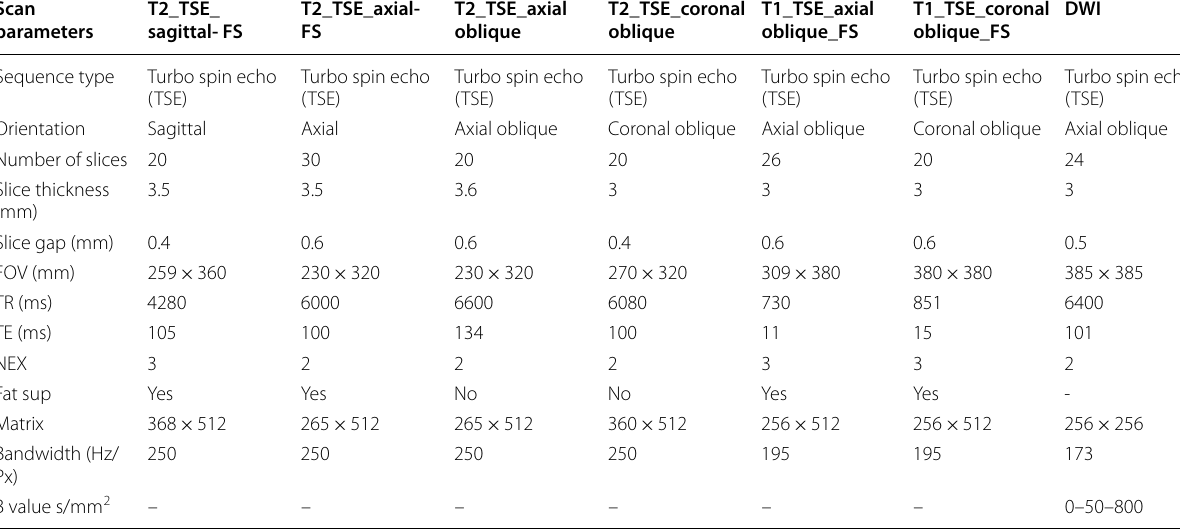
Table 1 Protocol and applied sequence parameter in 1st institution with 1.5 Tesla system (Toshiba Vantage Titan, agent Japan) Scan